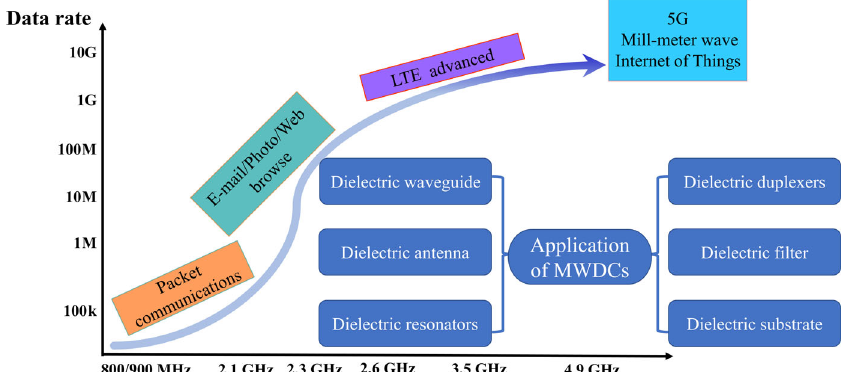
Fig. 1 Applications of MWDCs in different